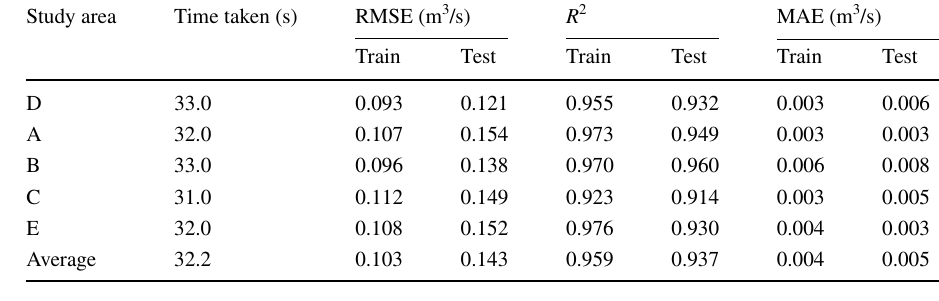
performance of the hybrid BA-ANN model at five selected study